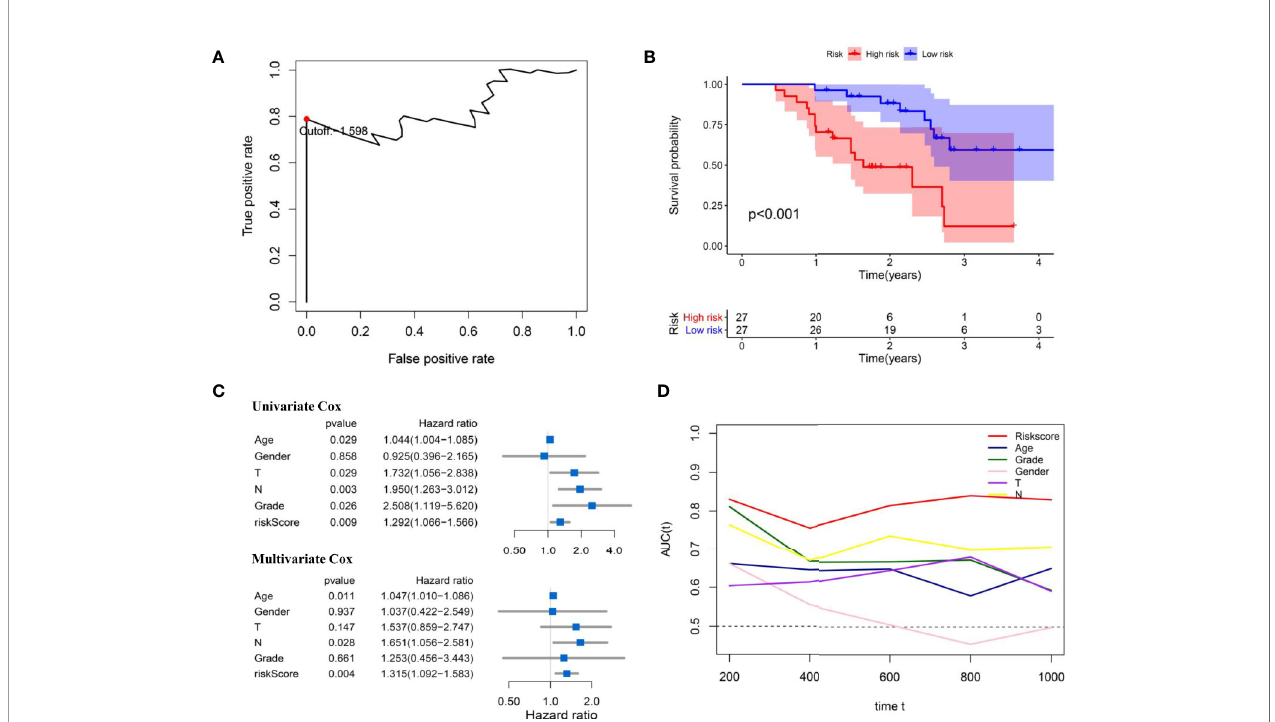
FIGURE 10 | External validation of IRL-signature in Zhengzhou cohort. (A) Time-dependent ROC curve of IRL-signature in Zhengzhou cohort. The optimal cut-off value of LncRNA signature is -1.598, and patients are divided into high-risk group and low-risk group according to the cut-off value. (B) Kaplan-Meier survival curve of IRL-signature in Zhengzhou validation cohort. (C) Forest plot for univariate and multivariate Cox regression analysis. (D) Time-dependent ROC curves and AUC of IRL-signature based on Zhengzhou validation